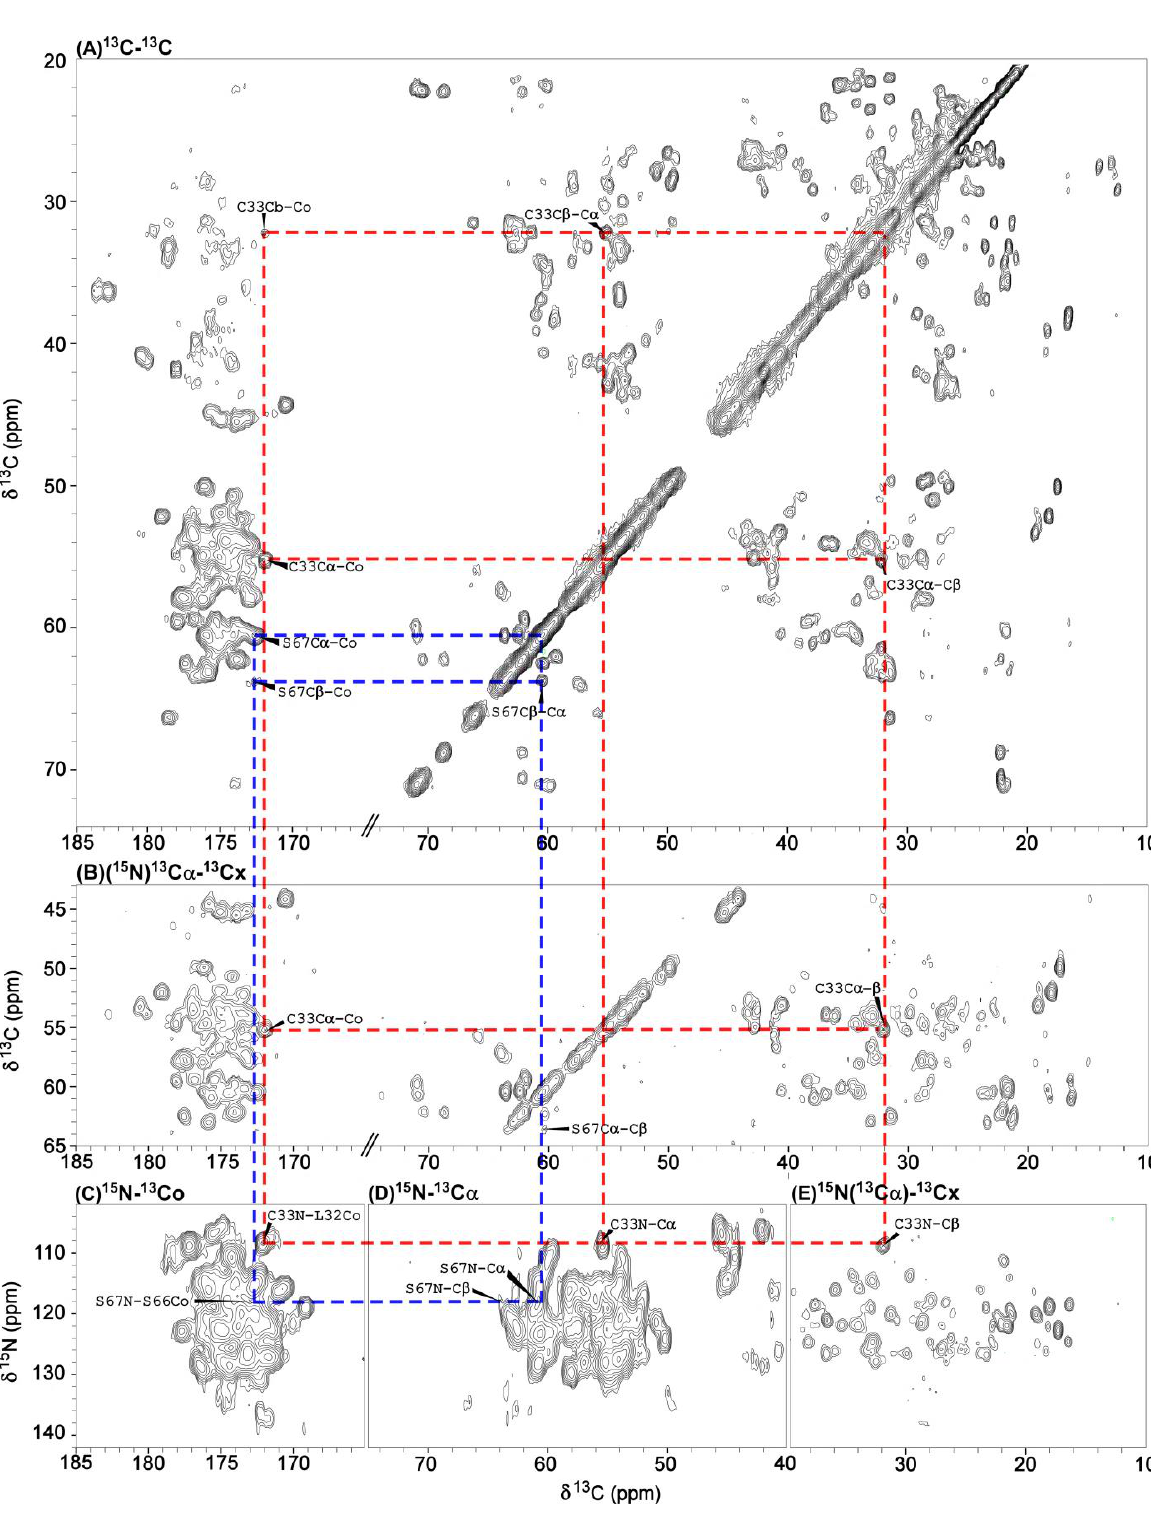
Figure 5. Four different spectra of U-gVp/NA-DNA complex. ( A ) The 2D 13 C- 13 C DARR spectrum acquired with a 5 ms mixing time (DARR5); ( B ) 2D ( 15 N) 13 Cα 13 Cx projection from 3D NCACX25; ( C ) 2D 15 N- 13 CO; ( D ) 2D 15 N- 13 Cα; ( E ) 15 N( 13 Cα) 13 Cx projection from the 3D NCACX25 experiment. Sequential assignments of S67 and C33 are indicated using blue and red dashed lines, respectively. All spectra were processed with a sine-squared window function.